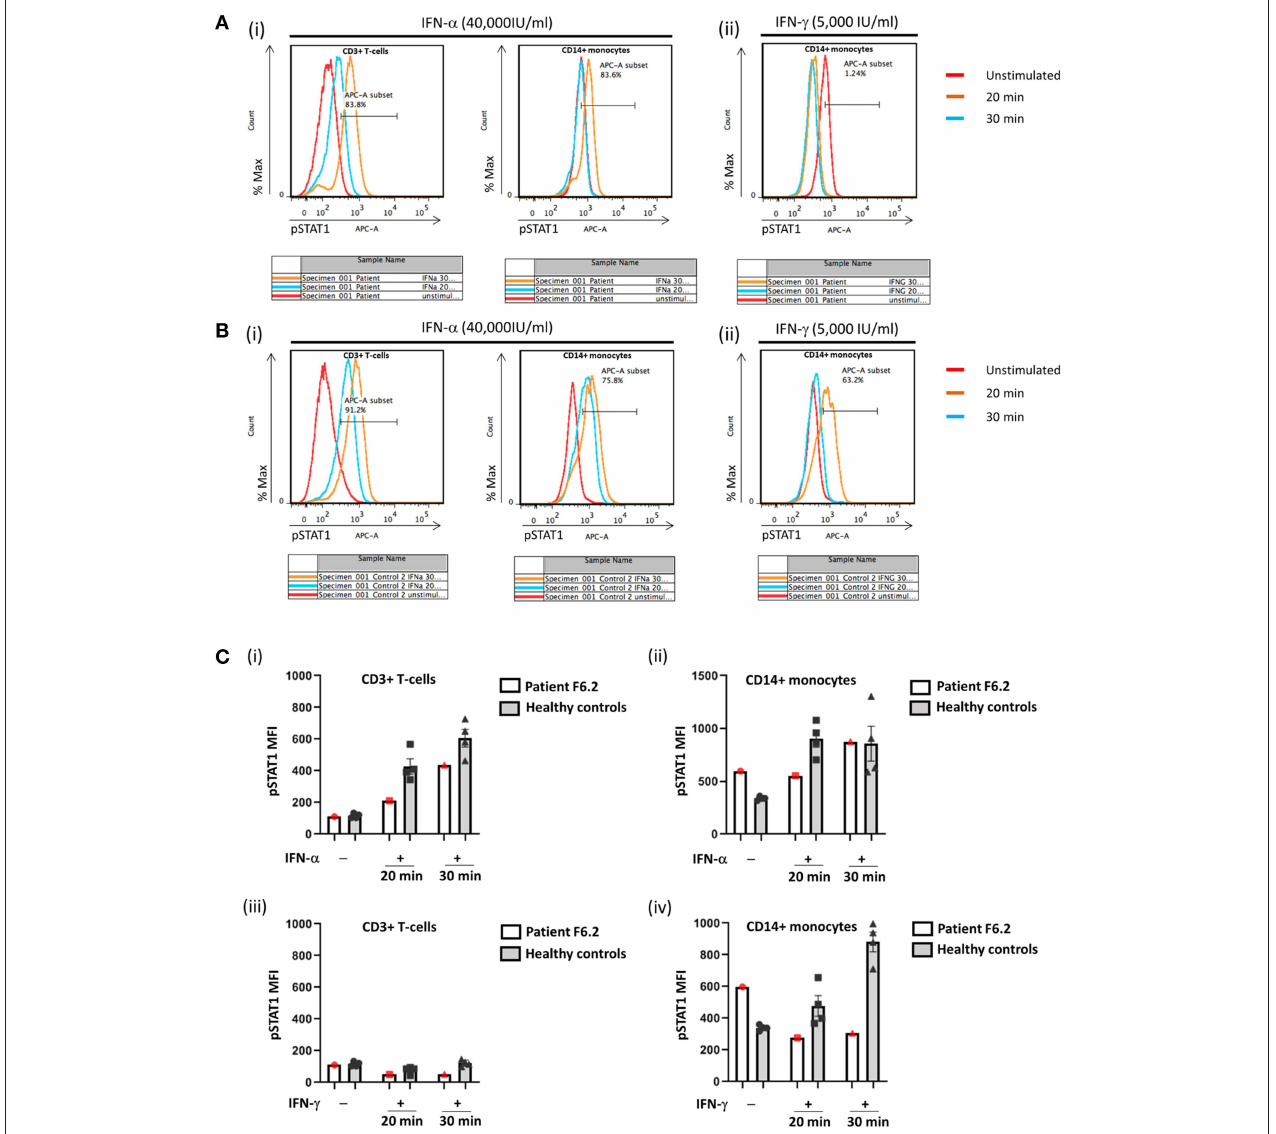
FIGURE 4 | Flow cytometric analysis of STAT1 phosphorylation (pSTAT1) in CD3 + T-cells and CD14 + monocytes in response to IFN- α and IFN- γ . Representative flow plots showing % pSTAT1 + cells in (A) Patient F6.2 and (B) a healthy control. Peripheral blood mononuclear cells (PBMCs) were stimulated with IFN- α (40,000 IU/ml) or IFN- γ (5,000 IU/ml) for 20 or 30min. Intracellular phosphorylated STAT1 (pSTAT1) was evaluated by gating on CD3 + and CD14 + cells in PBMCs stimulated with IFN- α (A i, B i ) and CD14 + cells in PBMCs stimulated with IFN- γ (A ii, B ii ) . (C) Mean fluorescent intensity (MFI) of pSTAT1 in Patient F6.2 and 4 healthy controls, data expressed as mean ±